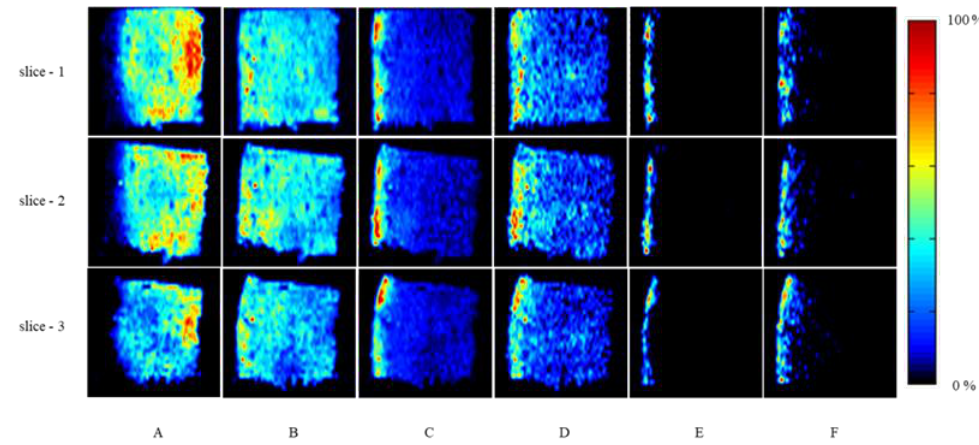
Figure 3. AFAI-MSI images of low molecular metabolites in mango: citric acid ( A ), malic acid ( B ), vitamin C ( C ), quinic acid ( D ), 5-galloylquinic acid ( E ), galloylglucose isomer ( F ). The color bar represents the relative intensity of compound ions.